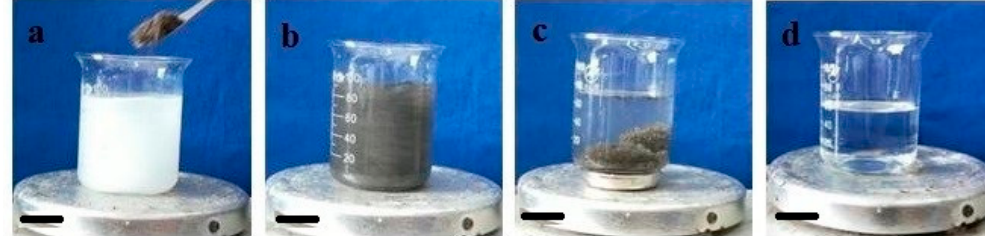
Figure 10. ( a ) The designed apparatus for separation of water-in-oil emulsion using SMSD; ( b–d ) the filtration process for separation of water-in-tetrachloromethane emulsion using SMSD. Scale bar, 3 cm.